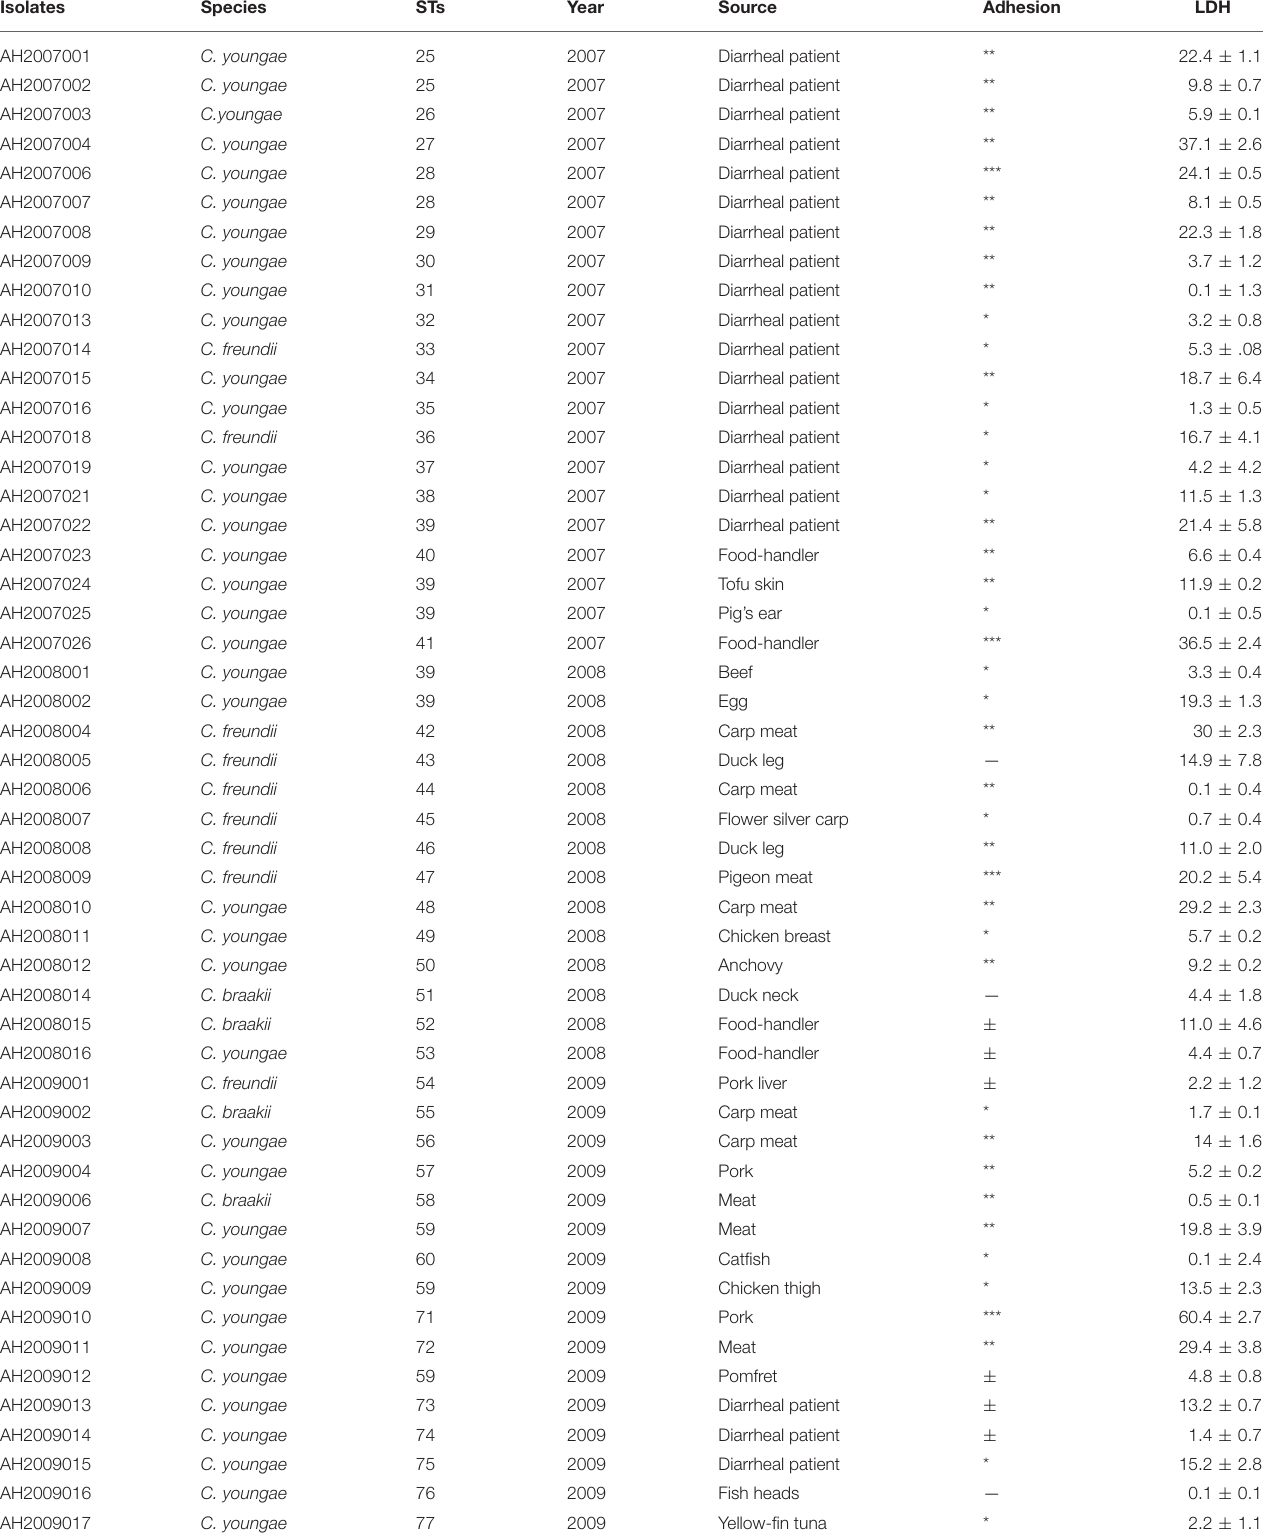
TABLE 1 | Citrobacter isolates used in this study and their characteristics. Isolates